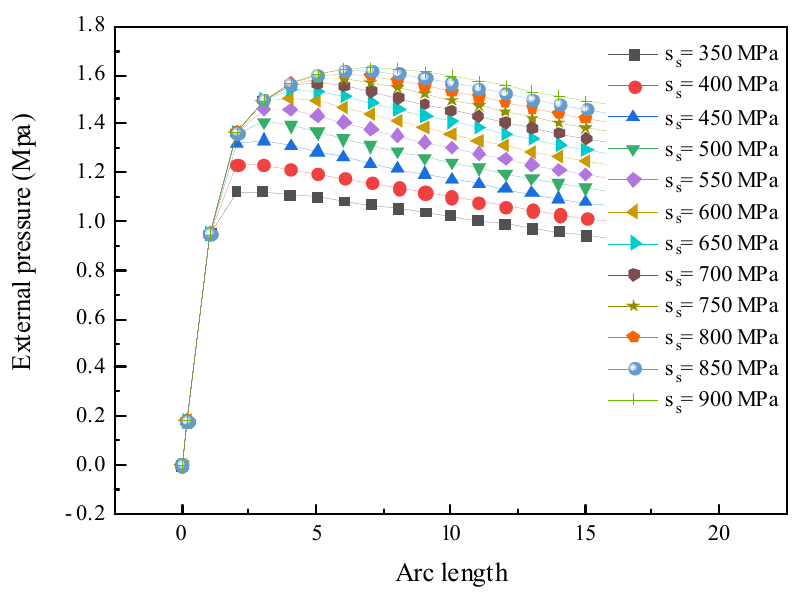
Figure 13. Collapse behavior curve with different yield stress.